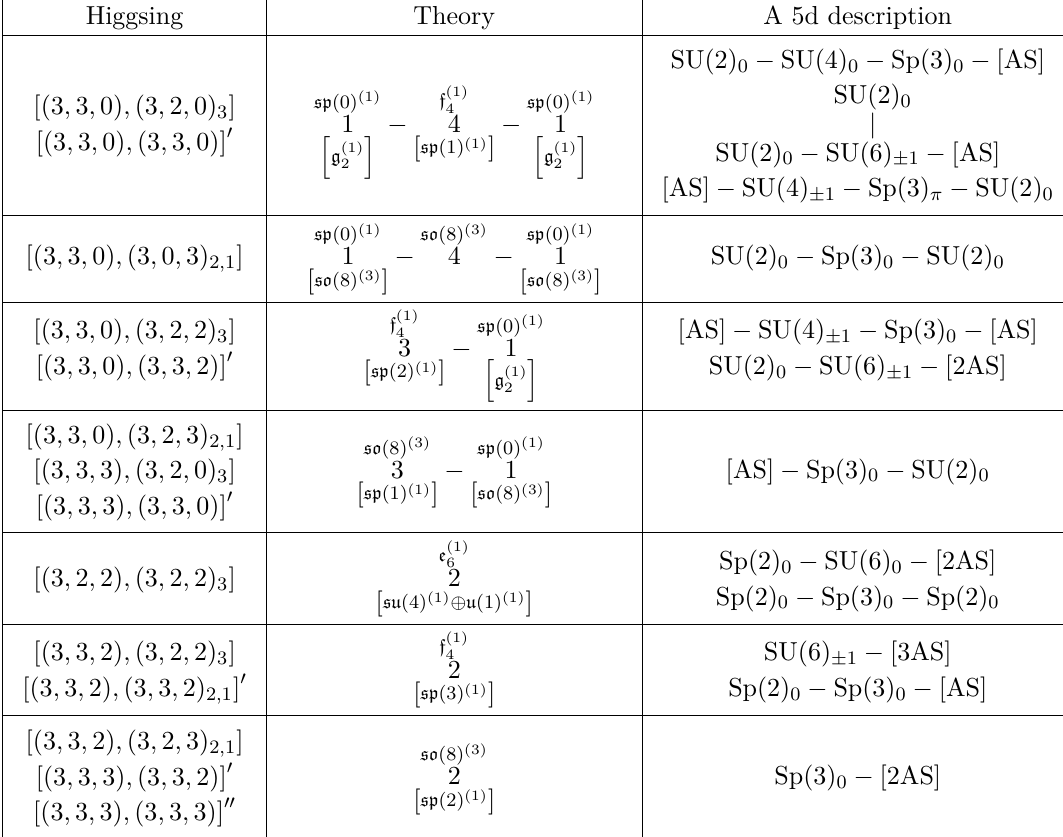
Table 4. Higgsings associated to SU(3) 3 × SU(3) 3 of (2.49). The table includes the cases where both ( a 1 , a 2 , a 3 ) and ( b 1 , b 2 , b 3 ) Higgs the e (1) algebra in (2.49). The other cases which is not listed 6 in this table can be obtained by the rule